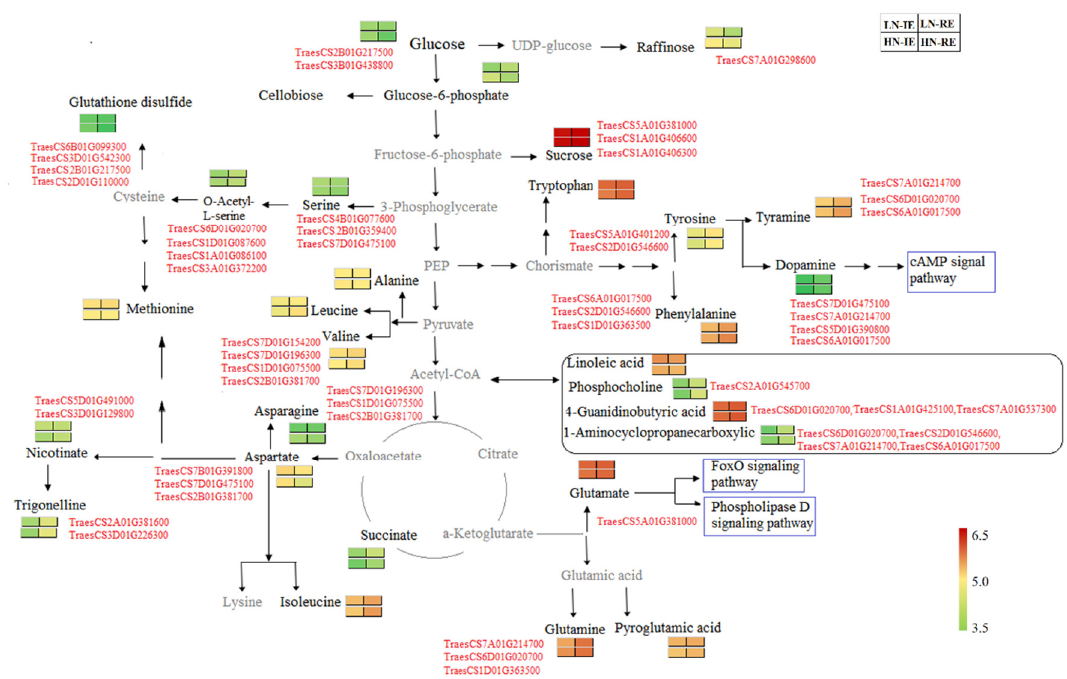
Figure 7. Schematic map of metabolic pathway involved in di ff erent regions of wheat grain endosperm grown under high nitrogen and low nitrogen conditions. The 2 × 2 heat map represent normalized (log10) relative metabolites abundance at di ff erent regions of endosperm under high and low nitrogen treatment with red color for a higher abundance and green color for a lower abundance. HN-IE and HN-RE are samples from innermost endosperm region and the remaining endosperm region under high nitrogen treatment, respectively. LN-IE and LN-RE are samples from innermost endosperm region and the remaining endosperm region under low nitrogen treatment, respectively. Metabolite in black color represent identified metabolite in this study.